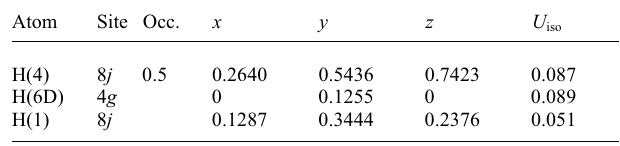
Table 3. Atomic coordinates and displacement parameters (in Å 2 ) .